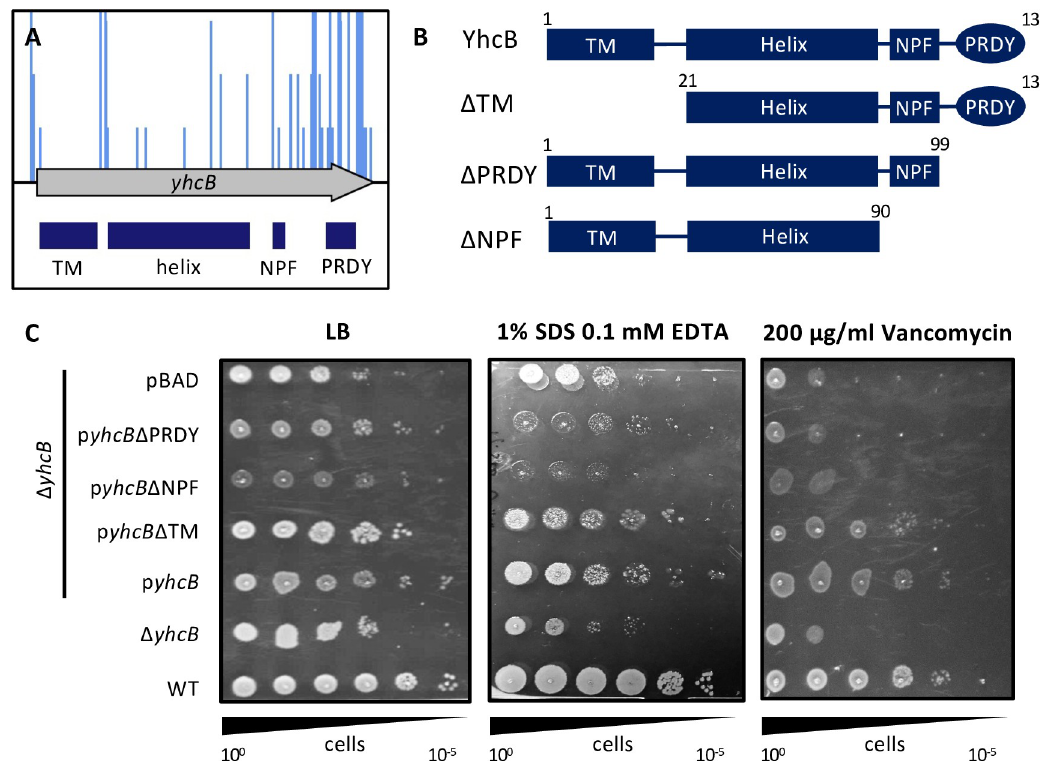
Fig 3. The structural and functional contribution of the domains of YhcB. (A) Polymyxin B TIS screen data (blue insertions) plotted above the gene track with the domains of YhcB mapped underneath (dark blue boxes). Insertion sites are represented by vertical bars and are capped at a frequency of 3. (B) Schematics of the plasmid-based YhcB complementation constructs. (C) Overnight cultures grown in LB supplemented with carbenicillin (for plasmid selection), normalised to an OD 600 of 1.00 and 10-fold serially diluted before inoculating LB agar plates supplemented with vancomycin or SDS and EDTA, with 0.2% arabinose. Abbreviations: TM = transmembrane domain. ‘NPF’ and ‘PRDY’ are conserved amino acid